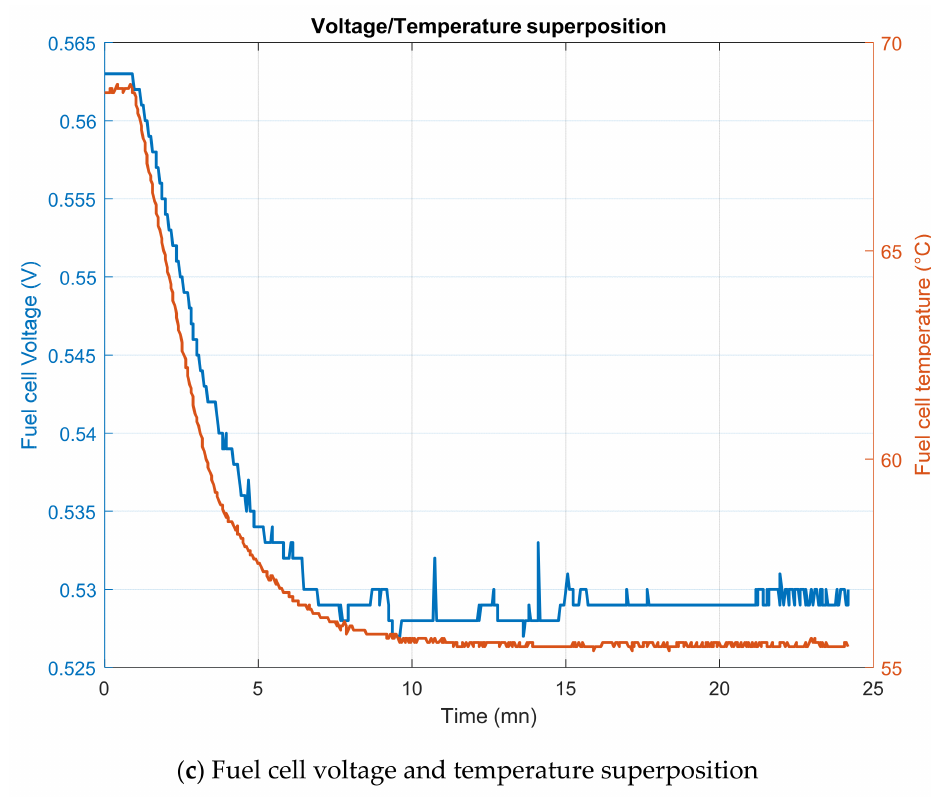
Figure 12. Pressure drop ( a ), oxygen flow rate ( b ) and temperature ( c ) superposition with the fuel cell voltage for the test case 2.